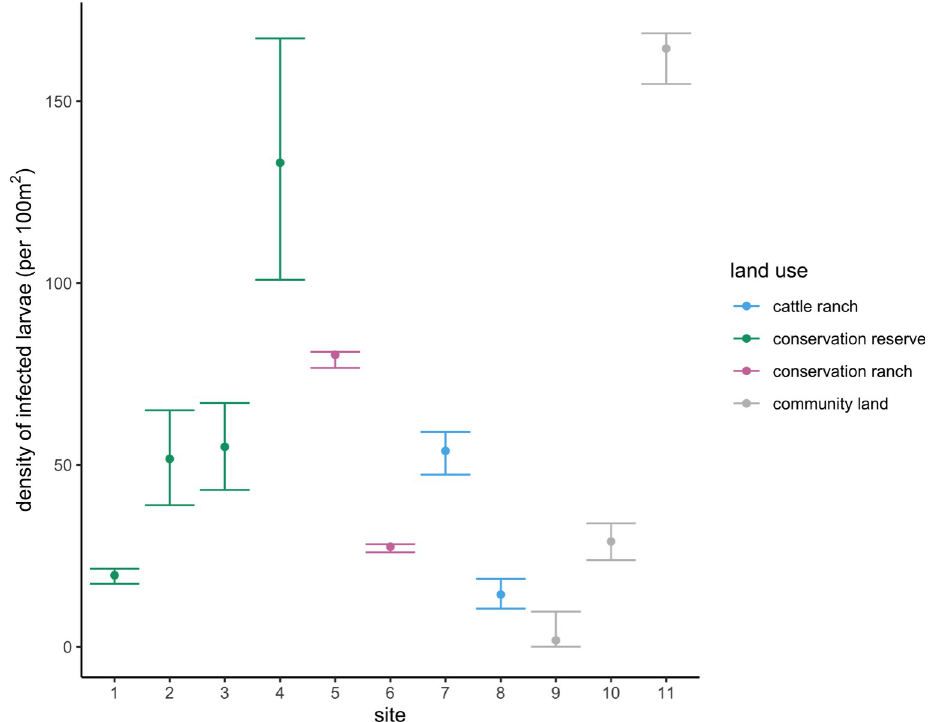
Fig 2. Density of Amblyomma hebraeum larvae infected with Rickettsia africae at the 11 sampling sites surveyed in the dry season of 2018, from which we estimated infection prevalence. There was no significant difference by land use